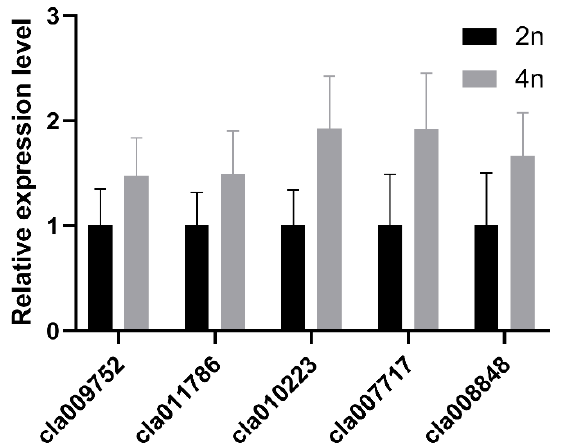
Figure 6. qRT-PCR analysis of five differentially expressed genes selected randomly between diploid and tetraploid watermelon. Cla009752 , chlorophyll a/b binding protein 21; cla011786 , thioredoxin m; cla010223 , low-temperature inducible; cla007717 , cytochrome b6-f complex iron–sulfur subunit; cla008848 , phosphoribulokinase/uridine kinase. ClACTIN was used as endogenous control. Expression level of diploid was set to 1. Data are means ± SD of three replicates.